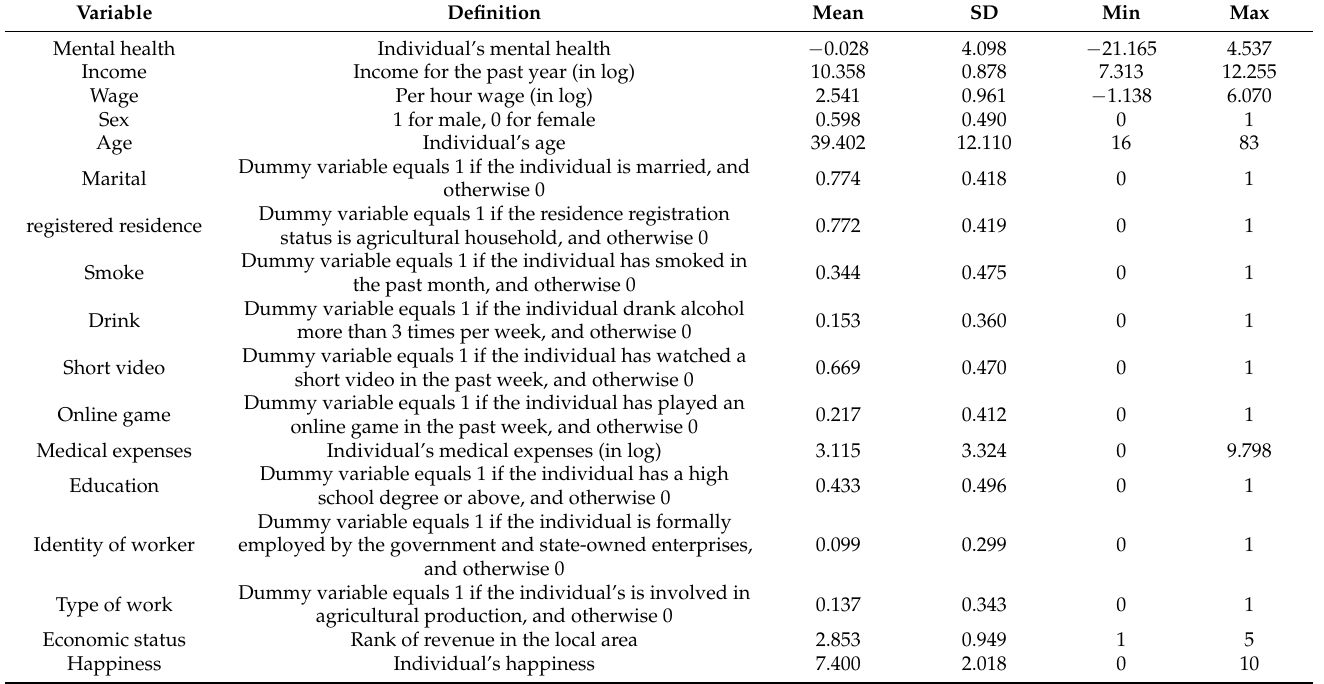
Table 1. Descriptive statistics of the key